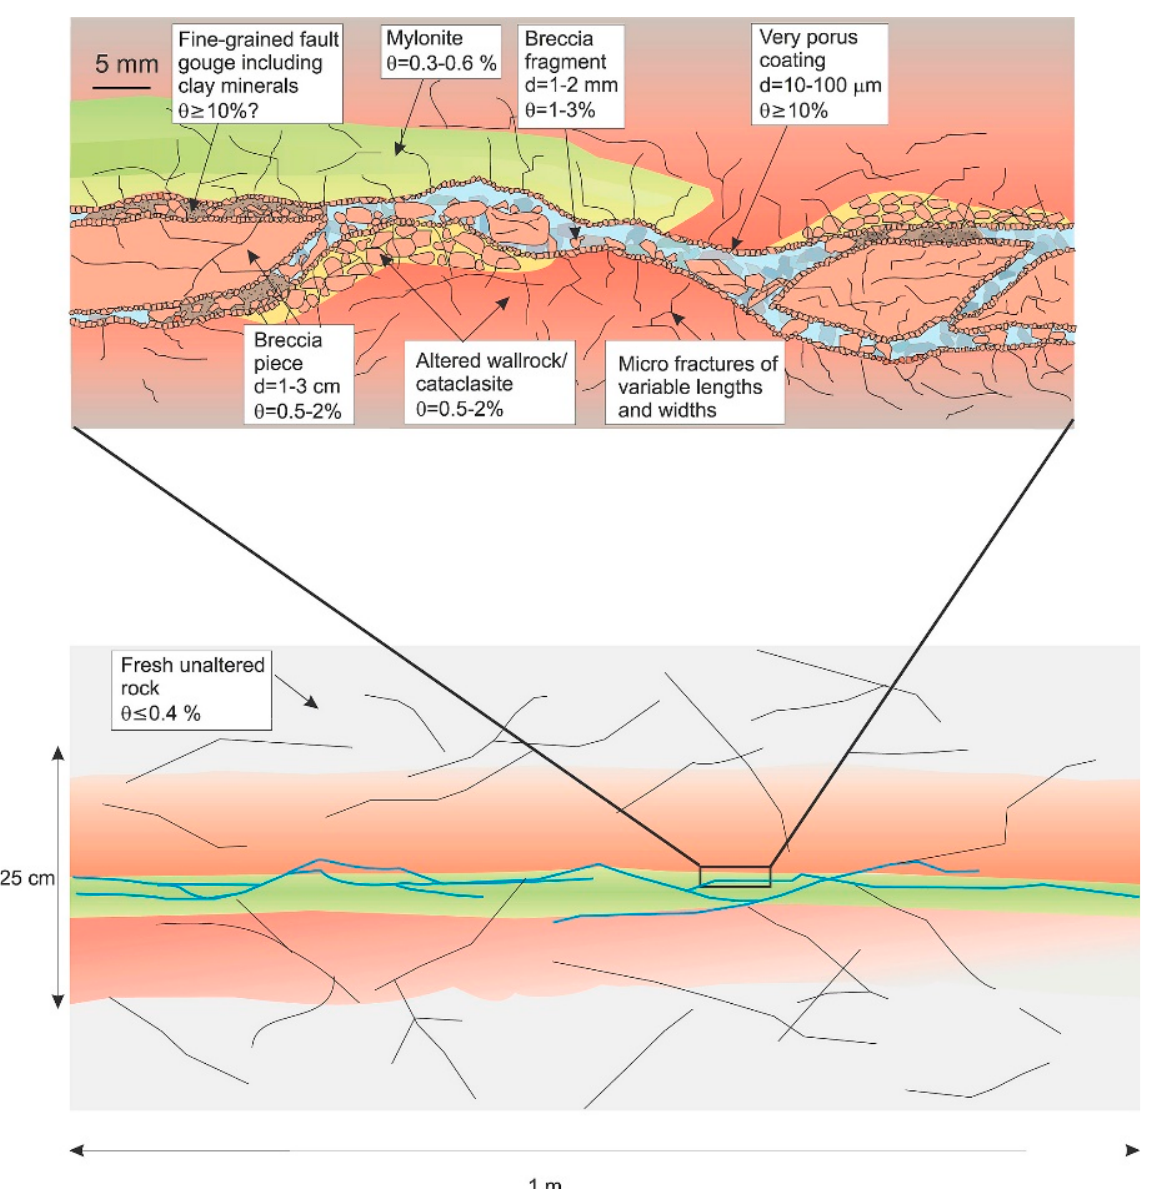
Figure 8. Conceptual figure of a single fracture with associated micro-structural model. In the figure, the symbol d represents aperture and the symbol θ porosity.